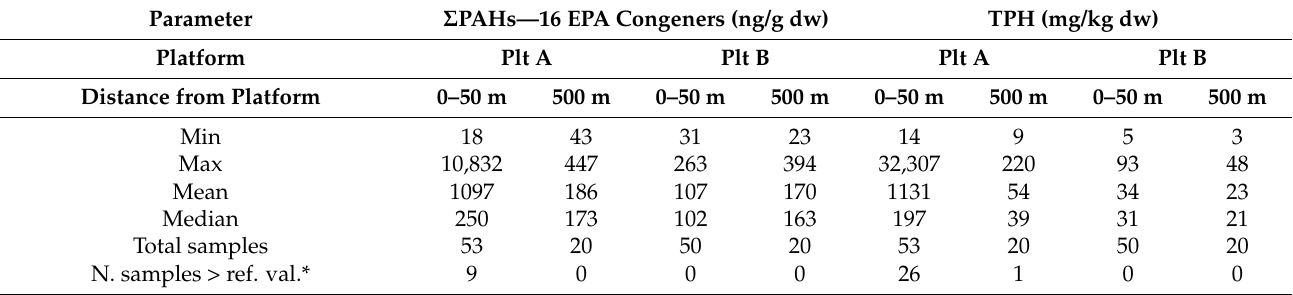
sediments from 2009 to 2017.